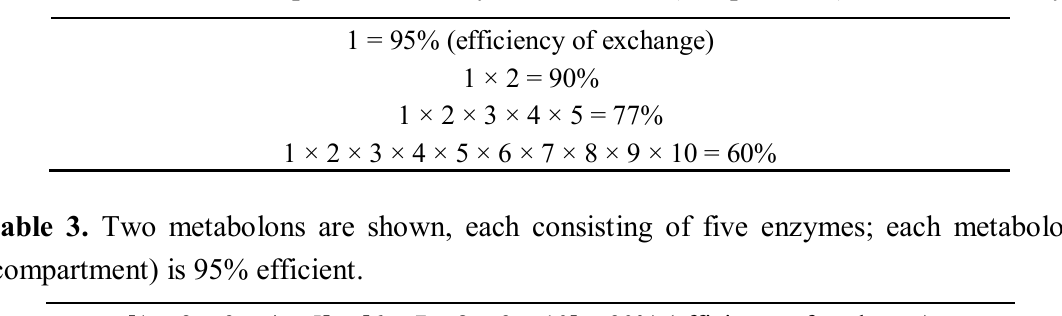
Table 2. Each numeral represents an enzymatic reaction (compartment) at 95% efficiency. 1 = 95% (efficiency of exchange) 1 × 2 = 90% 1 × 2 × 3 × 4 × 5 = 77%